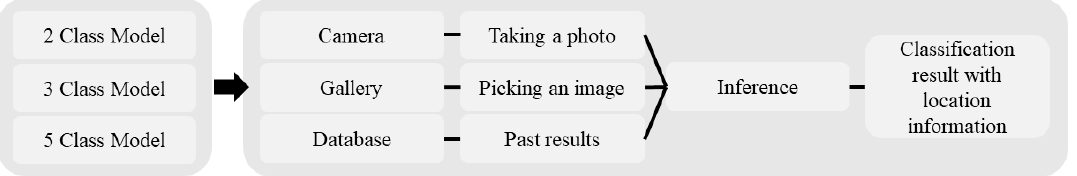
Figure 2. Flow chart of the PUMA. At the start, users were asked to select the classification model. There are two different ways of importing images which are from the live camera shots and from the image gallery. Once images are selected, the classifier automatically compares them against the pre-trained model and reports the classification results into the in-phone database. Database entry includes accuracy, classified name, date, time, and geographical locations.